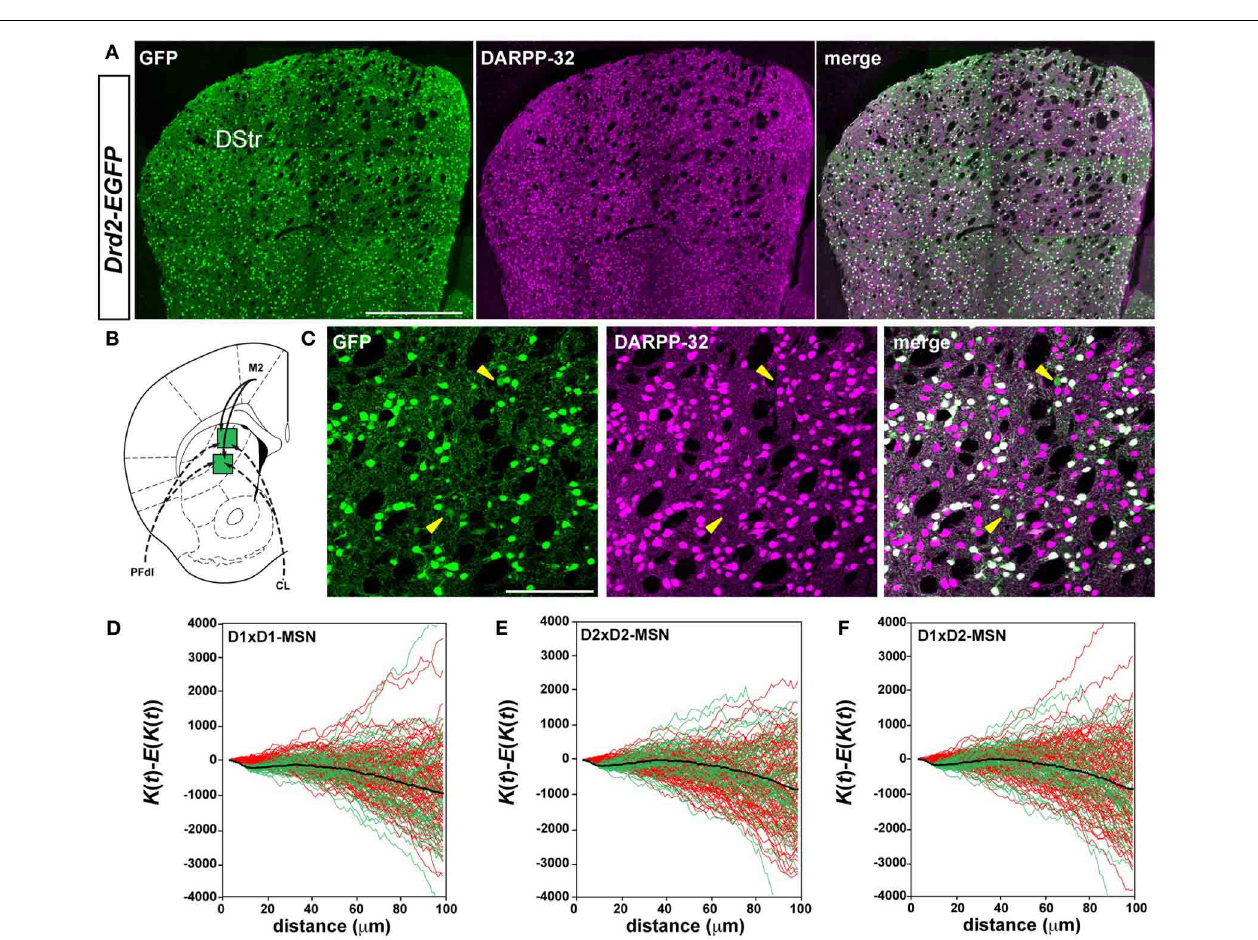
FIGURE 1 | D1R- and D2R-expressing MSNs are randomly distributed in the rostral part of the dorsal striatum. (A) Low magnification showing the distribution of GFP (green) and DARPP-32 (magenta) a marker of MSNs in the dorsal striatum of Drd2-EGFP mice ( n = 10). Scale bar, 500 μ m. (B) Schematic illustration of 2 striatal sectors analyzed, known to receive inputs from M2 (motor cortex, solid lines), from two thalamic nuclei (dotted lines), PFdl (dorsolateral parafascicular nucleus) and CL (centrolateral nucleus). (C) Representative images showing DARPP-32 immunoreactivity (magenta) and GFP (green) in the dorsal striatum of Drd2-EGFP mice used for spatial distribution analysis. Yellow arrowheads identify putative ChAT interneurons